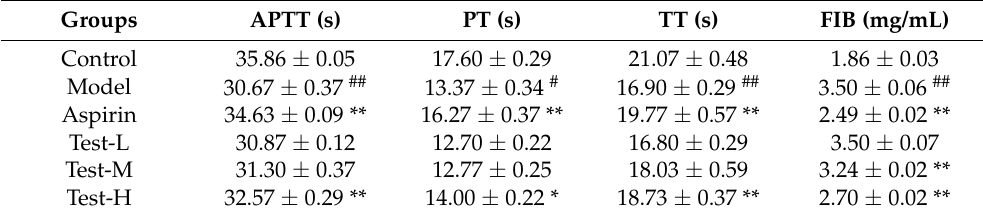
Table 1. Effects of AAP-b2 on activated partial thromboplastin time (APTT), prothrombin time (PT), thrombin time (TT) and fibrinogen (FIB) in thrombus mouse